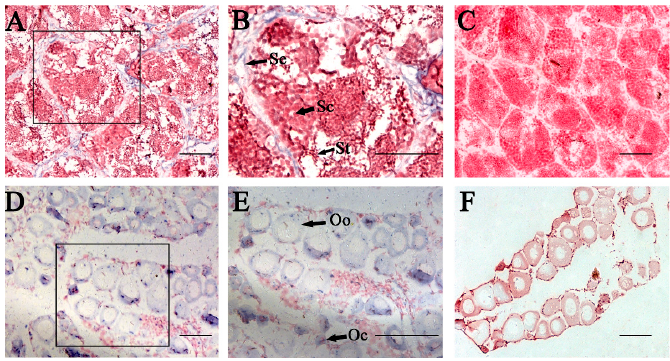
Figure 8. Analysis of mRNA expression of P. olivaceus GATA6 in adult gonad by using in situ hybridization (ISH). The positive cells ( A , B , D , E ) were stained with purple or blue, whereas the negative control with sense probe hybridization ( C , F ) was unstained. P. olivaeus GATA6 mRNA were observed in Sertoli cells ( B ), primary and secondary oocytes and oogonia ( E ). This experiment was done five times. Abbreviations: Se, Sertoli cells; Sc, spermatocytes; St, spermatids; Oo, oogonia; Oc, oocytes. Scale bars represent 100 μ m.